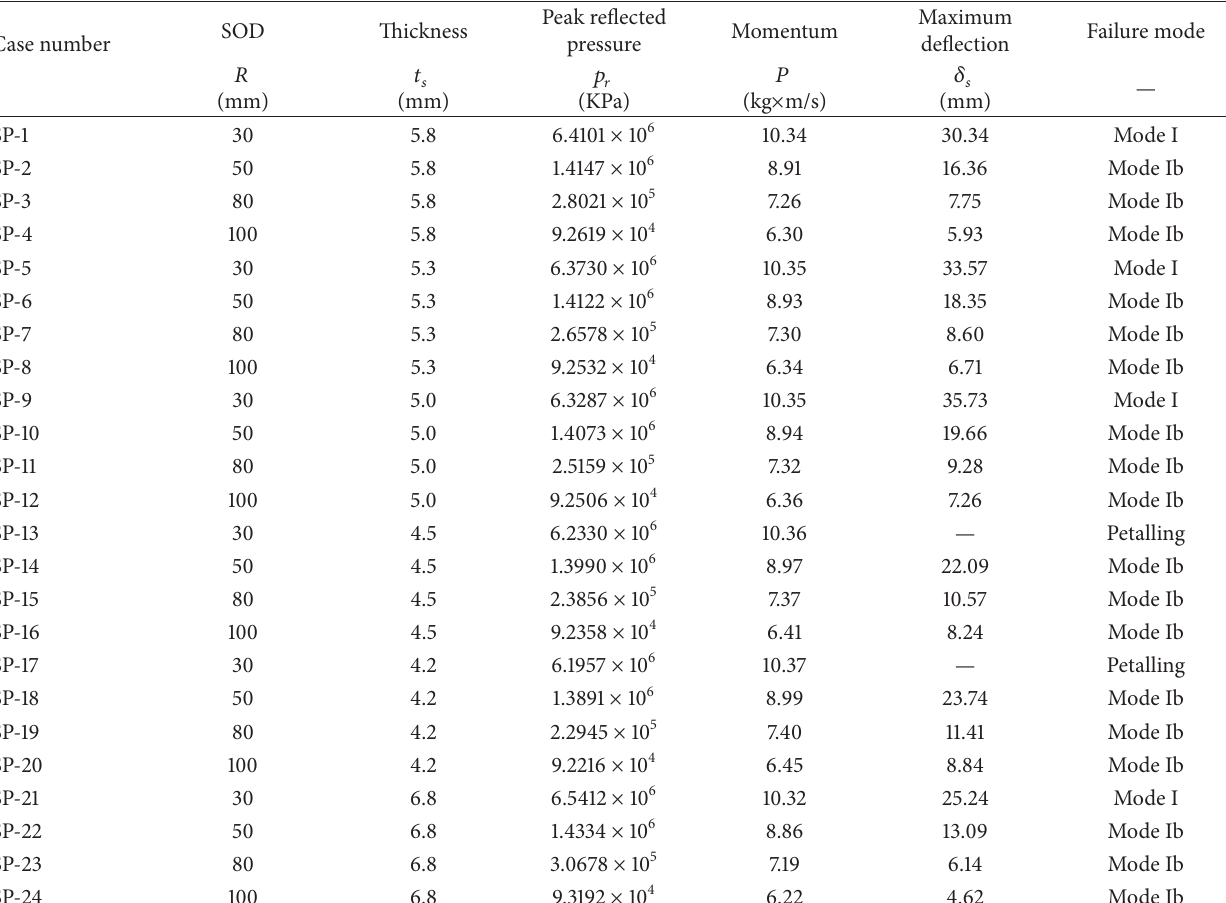
Table 2: Simulation results of equivalent solid plates.